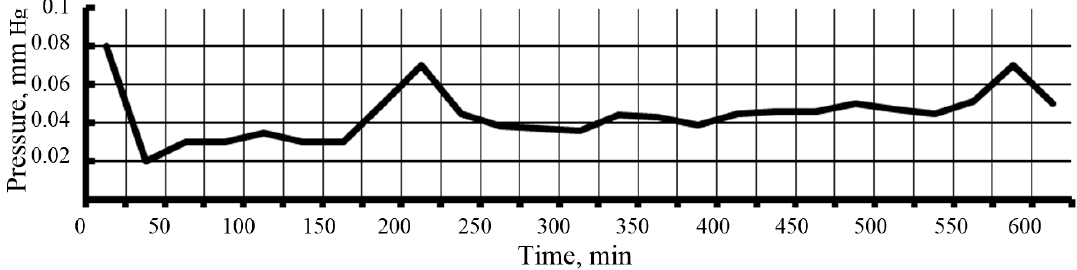
Figure 4. Dependence of pressure on time during sublimation upon receipt of a sample of nanopowder.